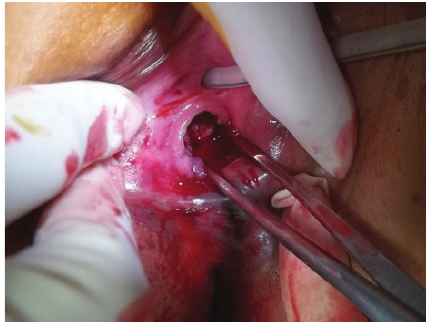
Figure 2: Laceration of the hymen and posterior